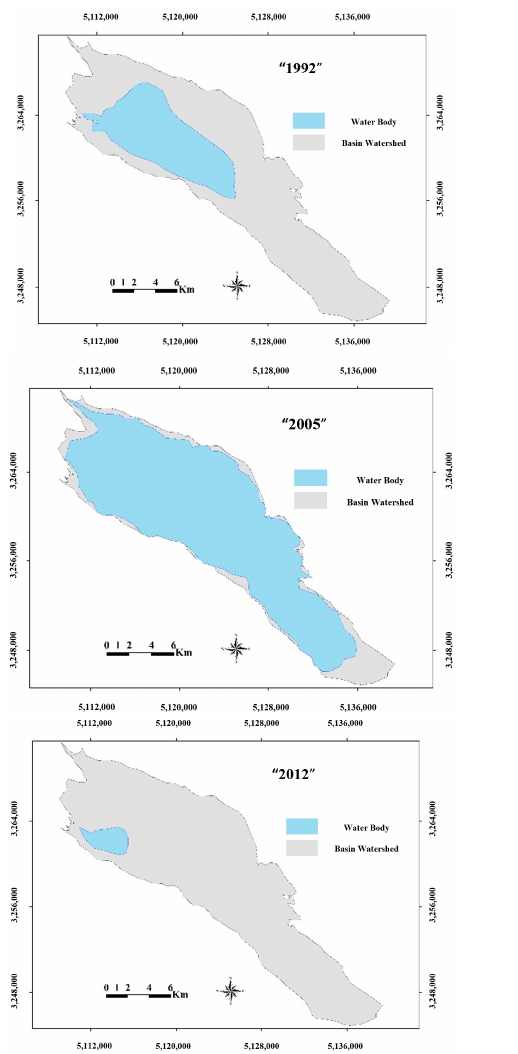
Table 3. Detected trend component in the lake’s surface area time series.